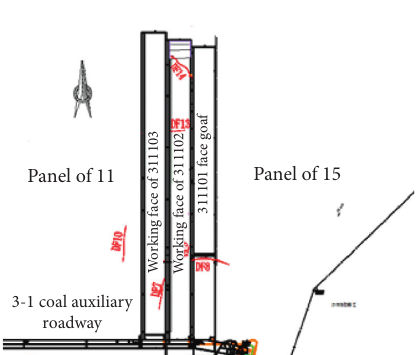
Figure 1: Schematic diagram of four-neighborhood relationships on working face of